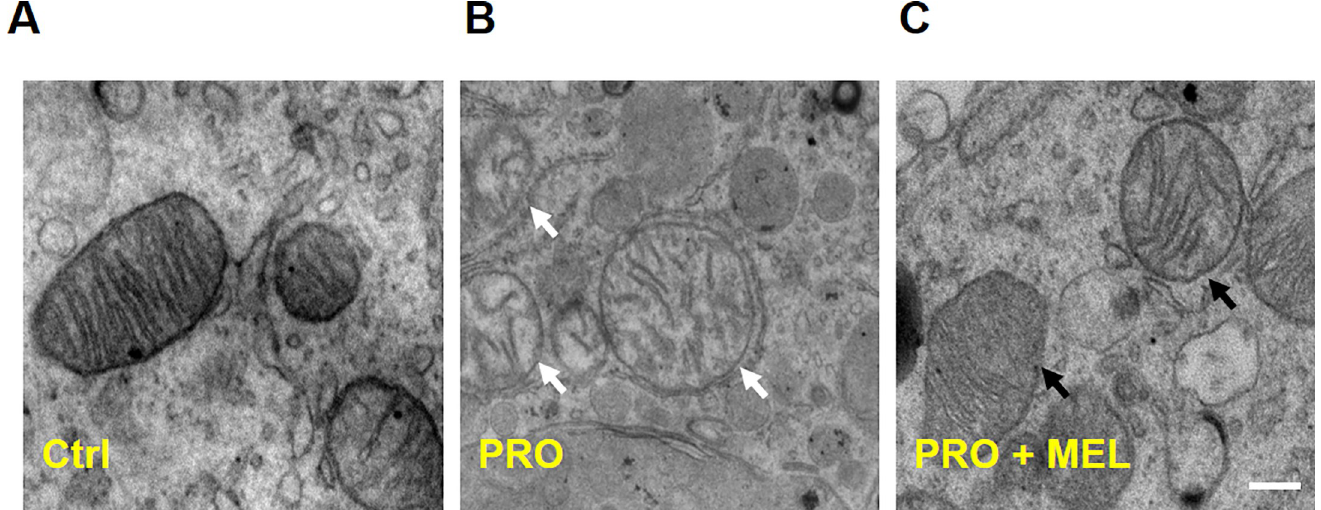
Fig 6. Transmission electron microscopic examination of ultrastructural morphology of mitochondria in microglia. Figures showed representative electron micrographs of microglia. The left column showed normal ultrastructural features of mitochondria (A), White arrows pointed to mitochondria with “dissolving” features in prorenin-stimulated microglia (B), and the right column showed melatonin cotreatment protected the normal ultrastructural morphology of the mitochondria (C), which revealed that melatonin markedly alleviated mitochondrial swelling, cristae disorientation and breakage compared with the prorenin- treated group. Scale bar = 1